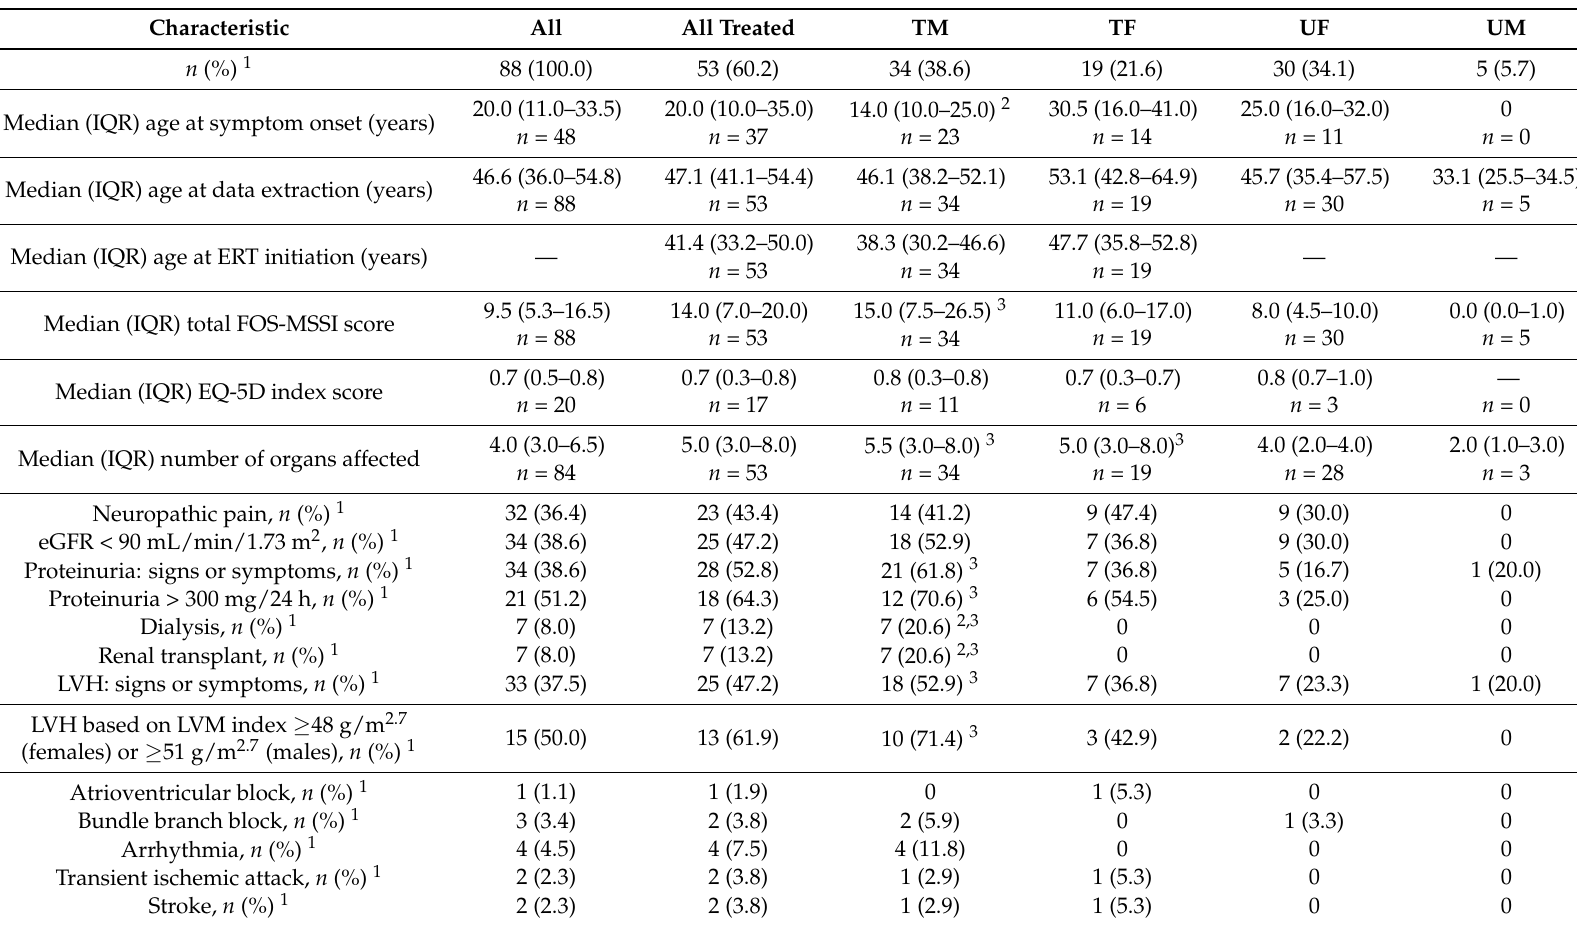
Table 1. Baseline clinical characteristics of Spanish patients with Fabry disease included in the FOS registry as of August 2014 by gender and treatment status. Characteristic All All Treated